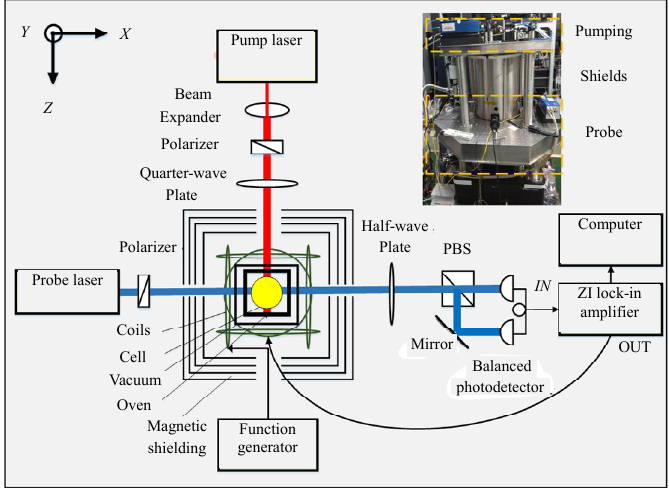
Fig. 2 Schematics of the experimental setup. The inset in the upper right corner is the photograph of the magnetometer. From top to the bottom are the pumping light path, the magnetic shields with sensing unit inside, and the probe light